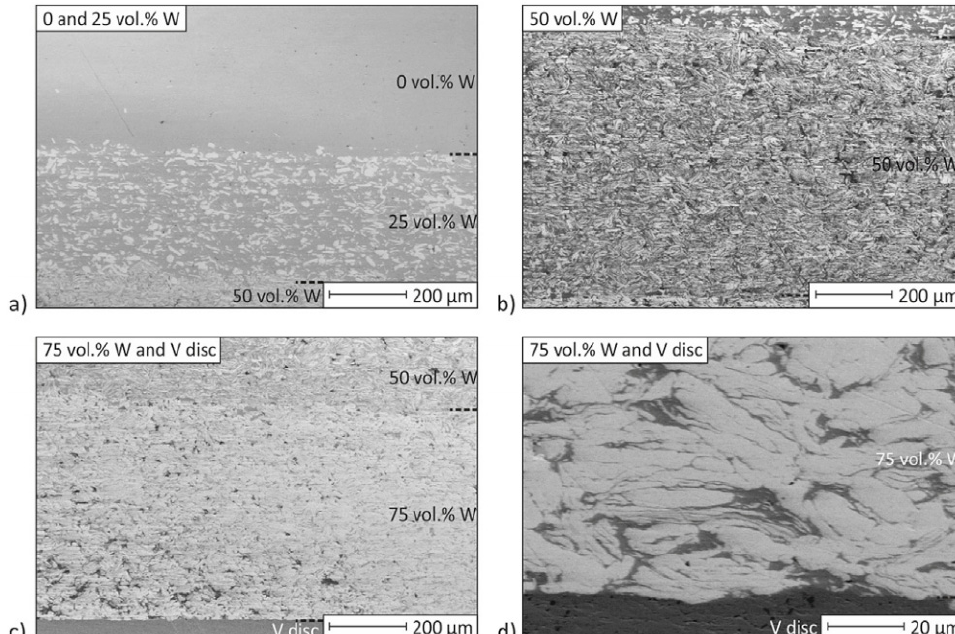
Figure 18. EDC processing of a graded Fe-W composite (0 to 75 vol.% W) joined to a V bulk disc: ( a ) sublayers with 0 and 25 vol.% W; ( b ) sublayer with 50 vol.% W; ( c ) sublayers with 50 and 75 vol.% W and V disc; and ( d ) magnification of the sublayer with 75 vol.% W and V disc. Reprinted with permission from ref. [88] Copyright 2019 Elsevier.